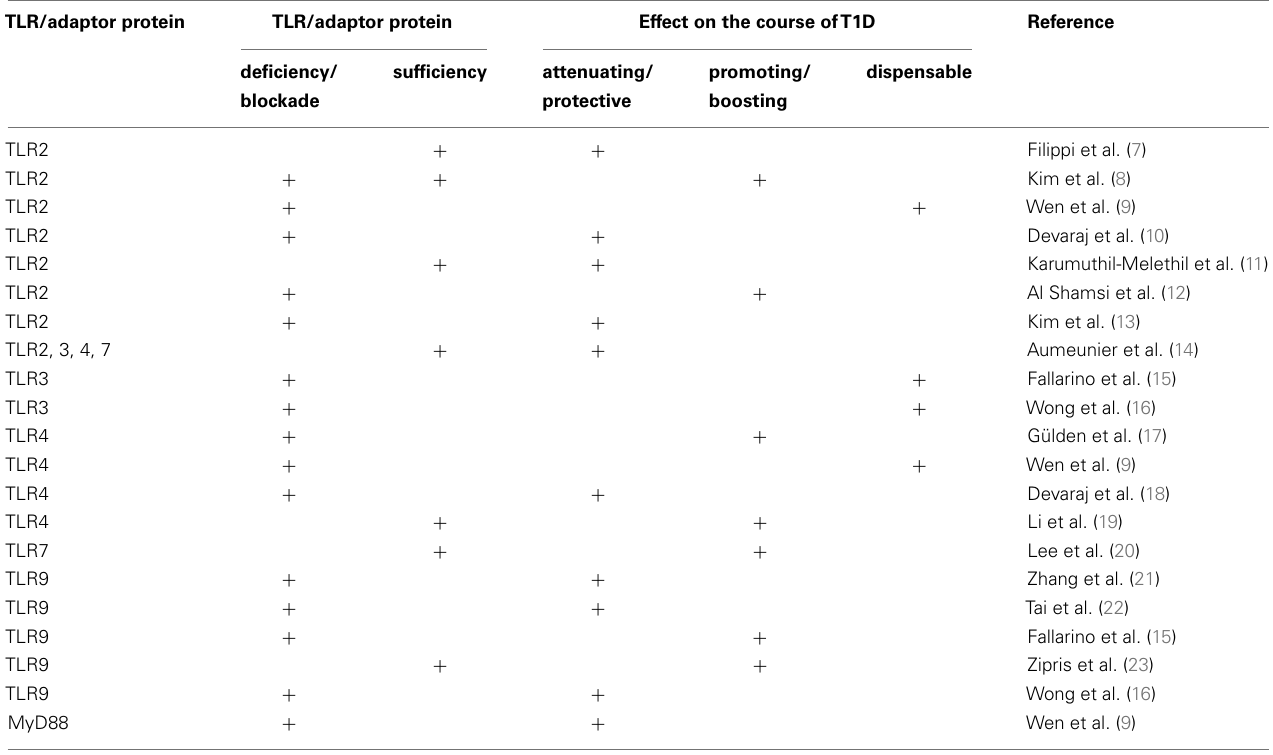
Table 1 |TLR-related studies in the field